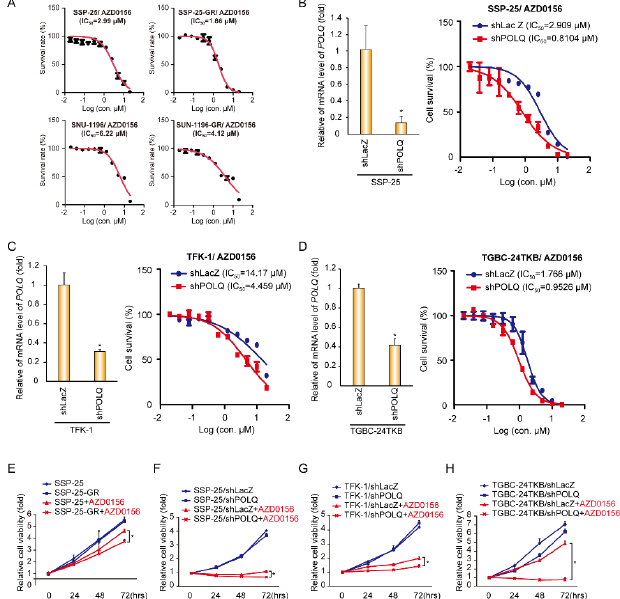
Figure 2. Knockdown of DNA polymerase θ increases AZD0156 sensitivity in BTC cells. ( A ) Cell Figure2. KnockdownofDNApolymerase θ increasesAZD0156sensitivityinBTCcells. ( A